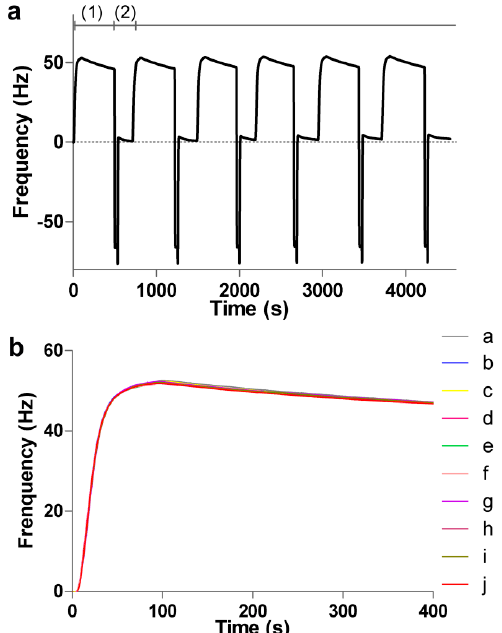
Figure 6. ( a ) Binding of myoglobin to the immobilized 3D carboxymethyl dextran (2000 kDa)